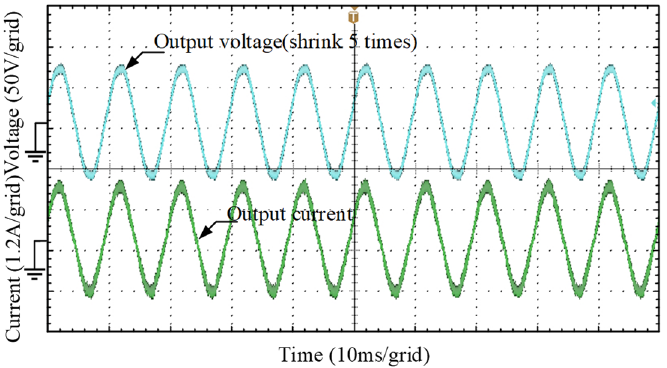
Figure 34. Output voltage and output current waveforms of reverse operation.